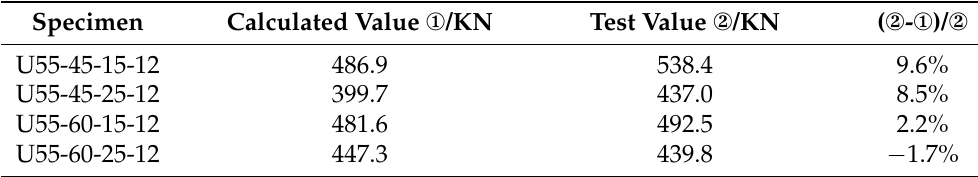
Table 3. Cracking load of steel–UHPC composite